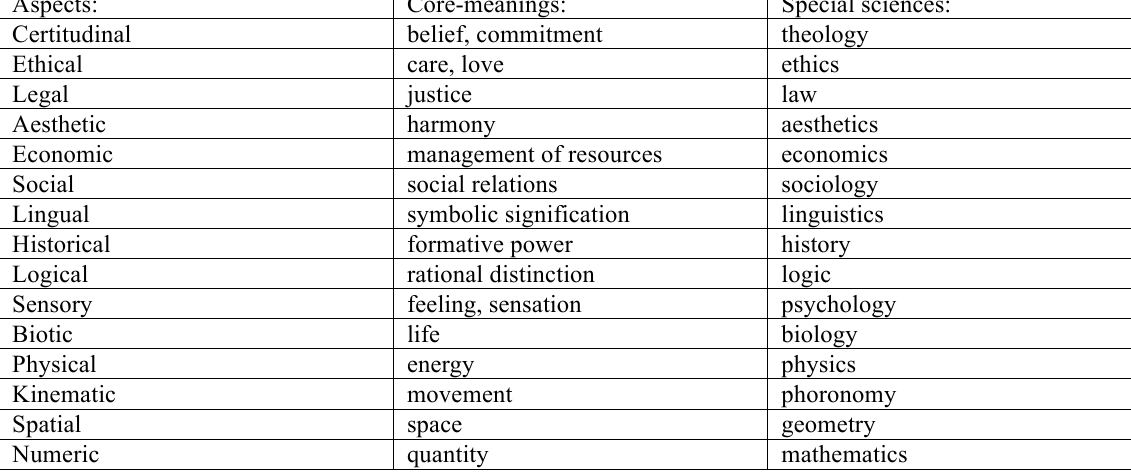
Figure 1: Modal aspects related to scientific disciplines